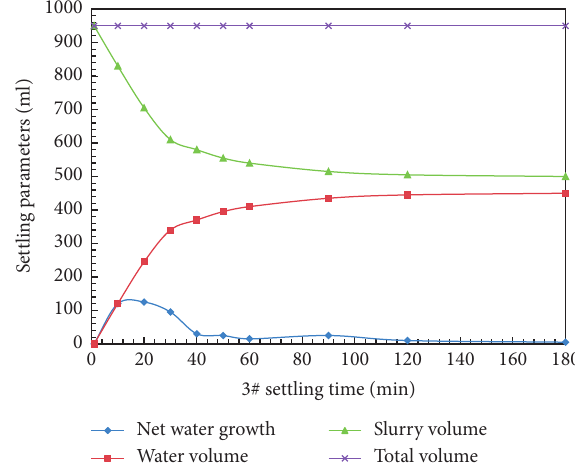
Figure 7: Flocculating sedimentation test parameters of tailings